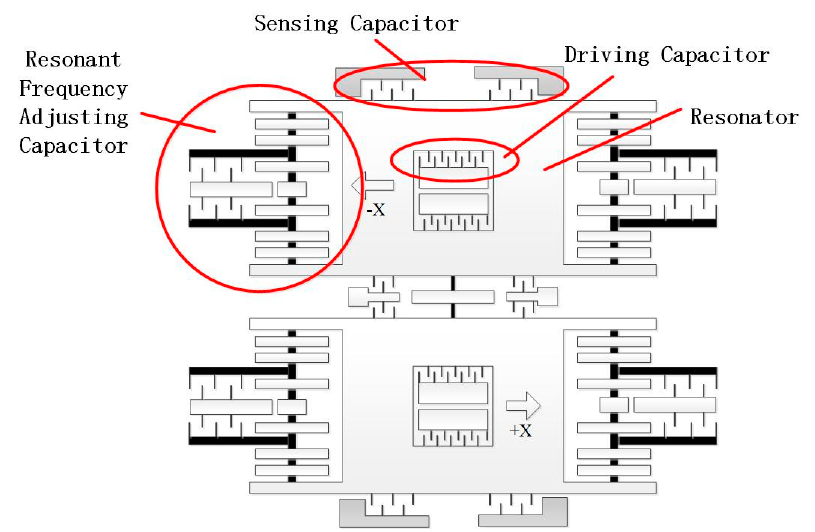
Figure 3. The structural design of the MEMS gyroscope. In accordance with Formula (4), when the frequency split of the resonant frequencies occurs in the X and Y directions due to the structure asymmetry, the output of the gyroscope would drift. The larger the frequency split is, the greater the introduced drift